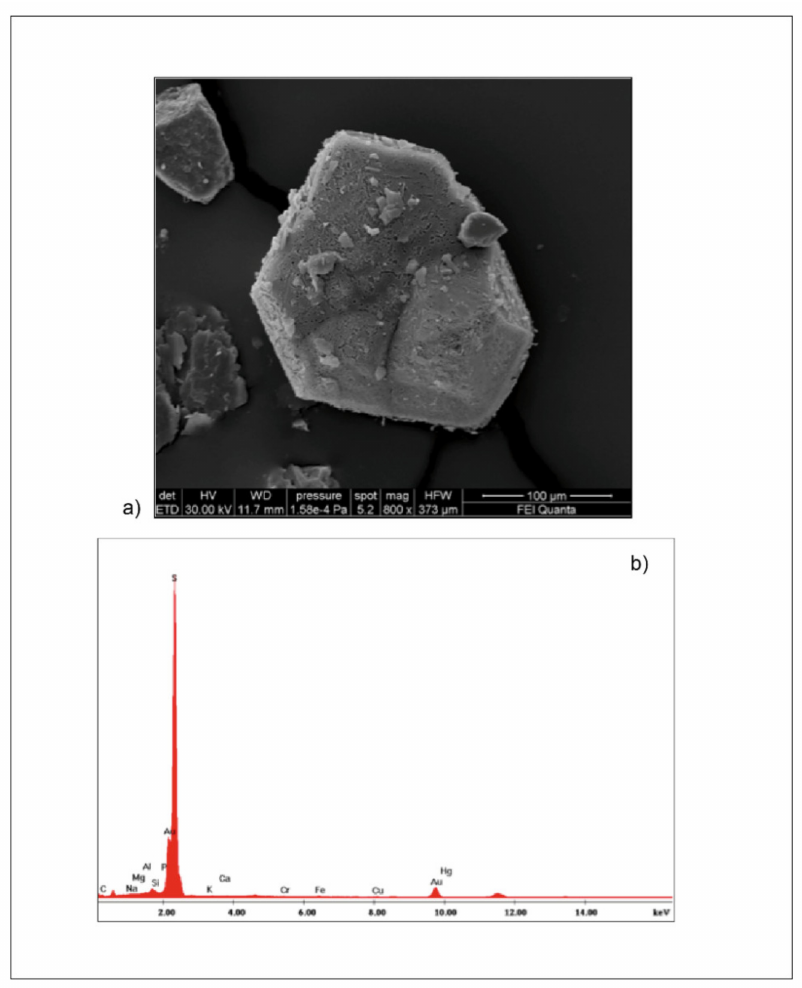
Figure 6. ( a ) SEM micrographs (scale bar = 100 µ m) and ( b ) EDS analysis of sulfur crystals collected in sample